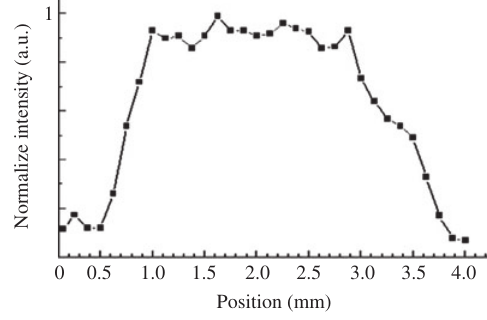
Fluorescence intensity as function of position along the diameter of a Roundup UltraMax droplet on a leaf precoated with a rhodamine 6G layer ( Hake et al. 2007